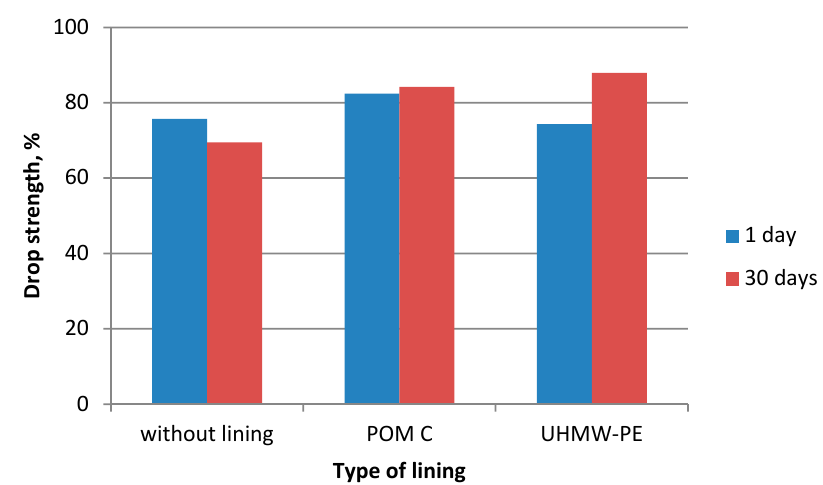
Figure 8. Drop strength of briquettes made of Mixture 2 (fertiliser).